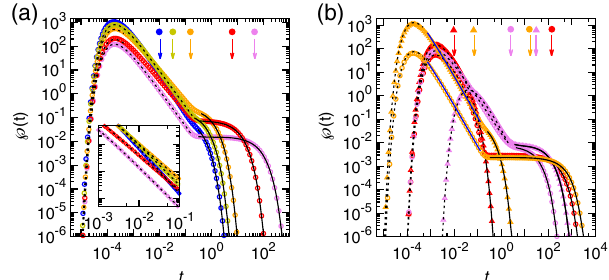
FIG. 3. FPT densities for various passive (a) and biased (b) diffusive systems along with mean FPT values (arrows). 0 . 006 , x 0 . 04 and ν ¼ − 1 = 2 (violet), ν ¼ − 1 = 4 (a) x 0 ¼ a ¼ (red), ν ¼ − 1 = 4 (orange), ν ¼ 1 = 2 (yellow), and ν ¼ 0 . 7 -strong subdiffusion (blue). The symbols represent results of numerical simulations (see Sec. II A), solid lines correspond to Eq. (6) (or the Poissonian limit for ν < 0 ), and dashed lines correspond to Eq. (9). Inset: Magnification of the intermediate regime with the asymptotic (10) depicted by dashed lines. Note that the long-time behavior for both ν < 0 cases is well within the Poisson-like regime. (b) One-dimensional diffusion under constant bias for 0 . 1 [orange; Pe ¼ − 5 (circles) and Pe ¼ 5 (triangles)], x 0 − x a ¼ 0 . 006 , x 0 . 04 2D diffusion with radial bias for x 0 ¼ a ¼ [red; Pe ¼ 0 . 75 (circles) and Pe ¼ − 0 . 75 (triangles)], and the 3 , x 2 . 5 (triangles), x 2 . 5 , OU process [violet; x 0 ¼ a ¼ a ¼ x 0 ¼ 2 . 4 (circles)]. The symbols represent results of numerical simulations (see Methods), solid lines correspond to Eq. (6) (or the Poissonian limit for ν < 0 ), black dashed lines correspond to Eqs. (9) and (15), respectively, and the blue solid lines correspond to Eq.